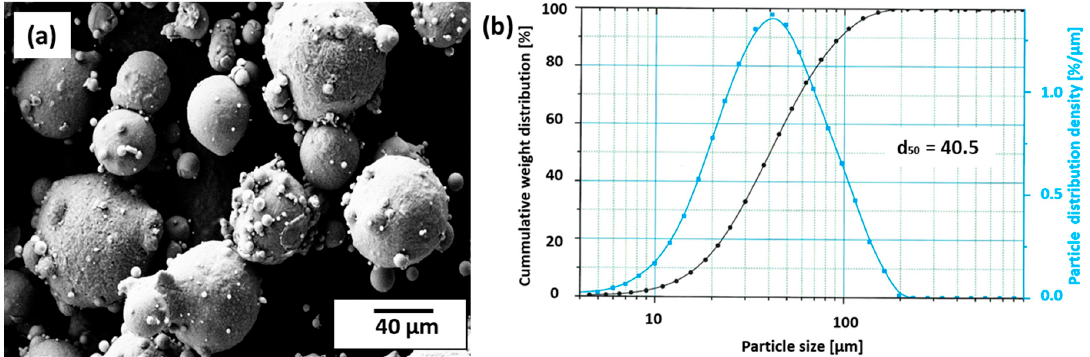
Table 1. Nominal composition (wt.%) of gas-atomized AlCu2.7Li1.8Mg0.3 powder.